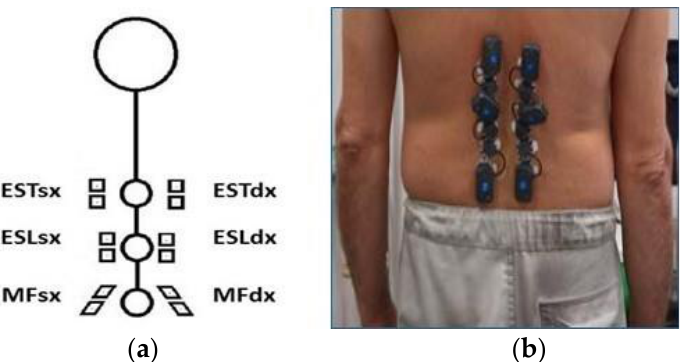
Figure 3. Example of the correct positioning of the electrode for EST assessment ( a ) and its placement on the operator’s back ( b ).